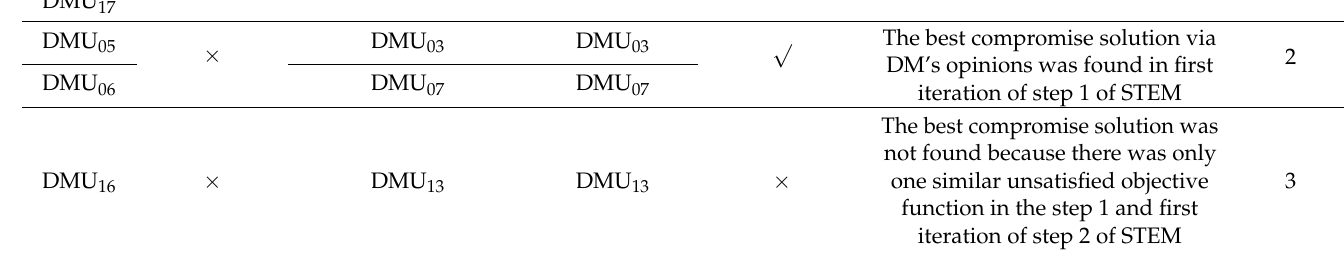
Member of DMU o